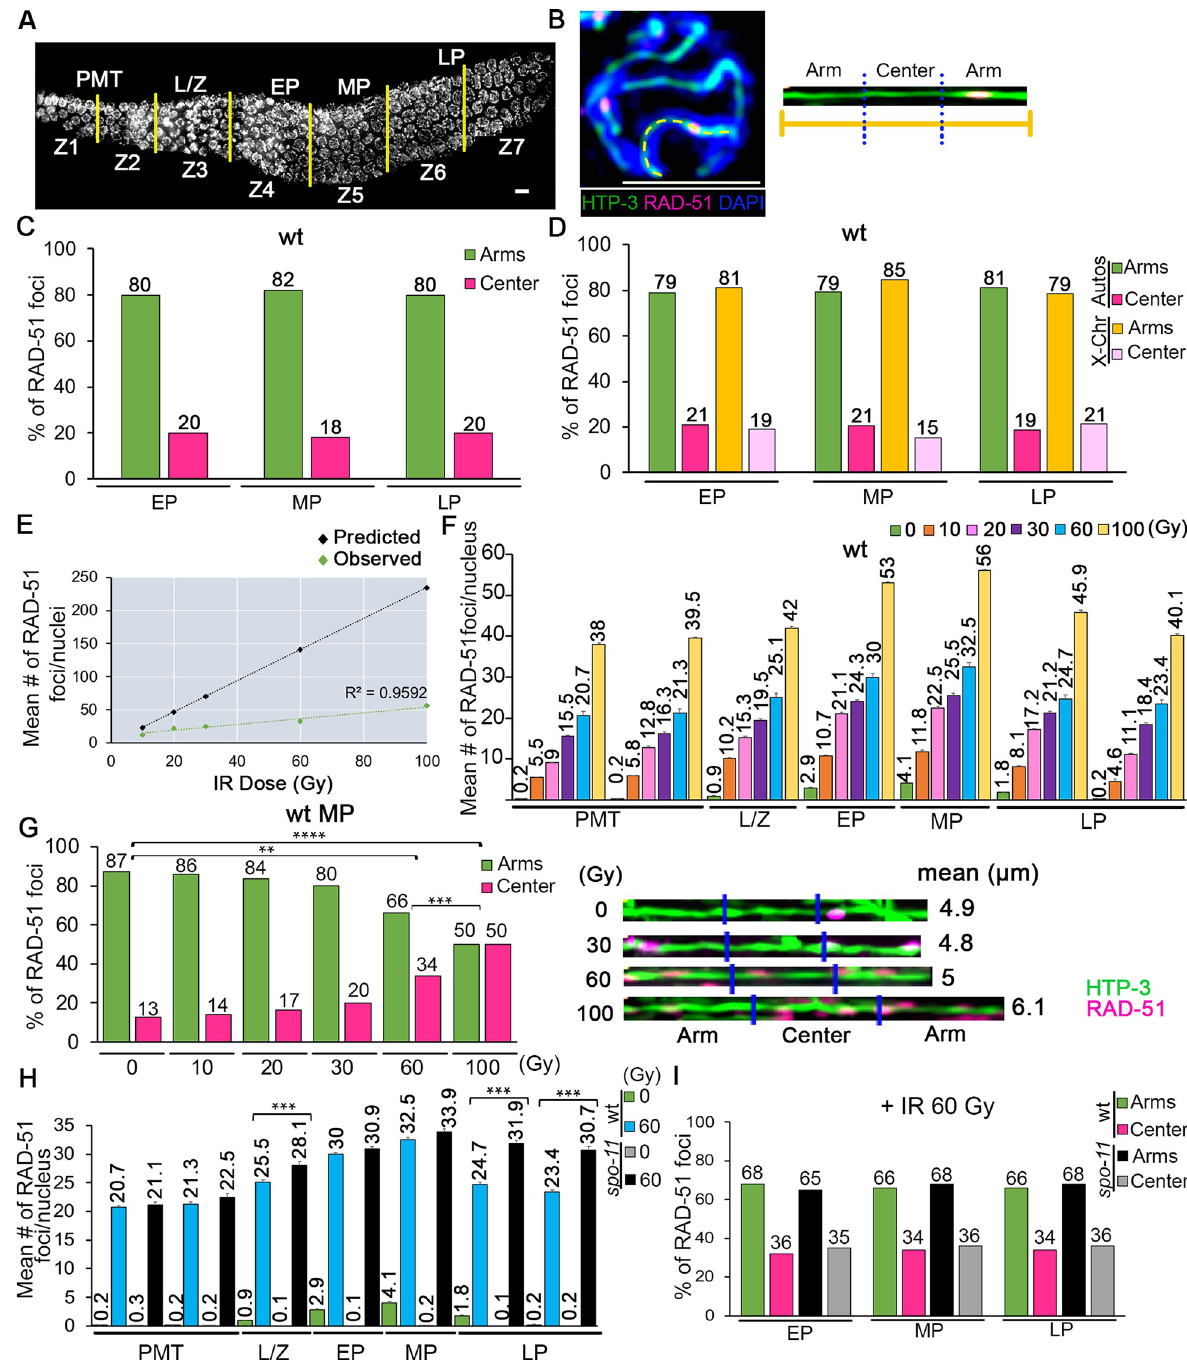
Fig 1. Distribution of meiotic RAD-51 foci is biased to the arms of the chromosomes throughout pachytene in normal conditions. (A) High- resolution image of a whole-mounted wild type hermaphrodite gonad stained with DAPI oriented from left to right. The different stages of meiotic prophase are indicated above the gonad and the seven equally sized zones scored for RAD-51 foci (Z1-Z7) are delimited by vertical yellow lines. Nuclei in Z1 and Z2 are undergoing mitosis. They enter meiosis at Z3, which corresponds to the leptotene/zygotene stages (L/Z). Nuclei then proceed through pachytene (Z4-Z7). PMT, pre-meiotic tip; L/Z, leptotene/zygotene; EP, early pachytene; MP, mid-pachytene; LP, late pachytene. (B) Left , high-magnification image of a halfway-projection of a mid-pachytene nucleus co-stained with anti-HTP-3 (green), to trace chromosome axes, and anti-RAD-51 (magenta), to mark DSB repair sites. Chromosome selected for linearization is indicated by a yellow dashed line. Right, chromosome computationally linearized and divided into three equal length portions referred to as arms and center. Scale bar, 2 μ m. (C) Histogram showing the distribution of RAD-51 foci at the center versus the arm regions of the chromosomes in different stages of meiosis in wild-type animals.